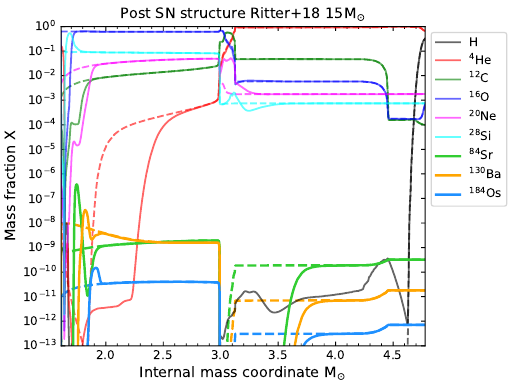
Figure 3. Abundance distribution before (dashed) and after (solid) the CCSN explosion in a 15 M ⊙ at Z = 0.02 [14]. In this particular case, the star experiences a C–O shell merger just before the explosion and the γ –process nuclei abundances are dominated by the pre-supernova production during the merger.